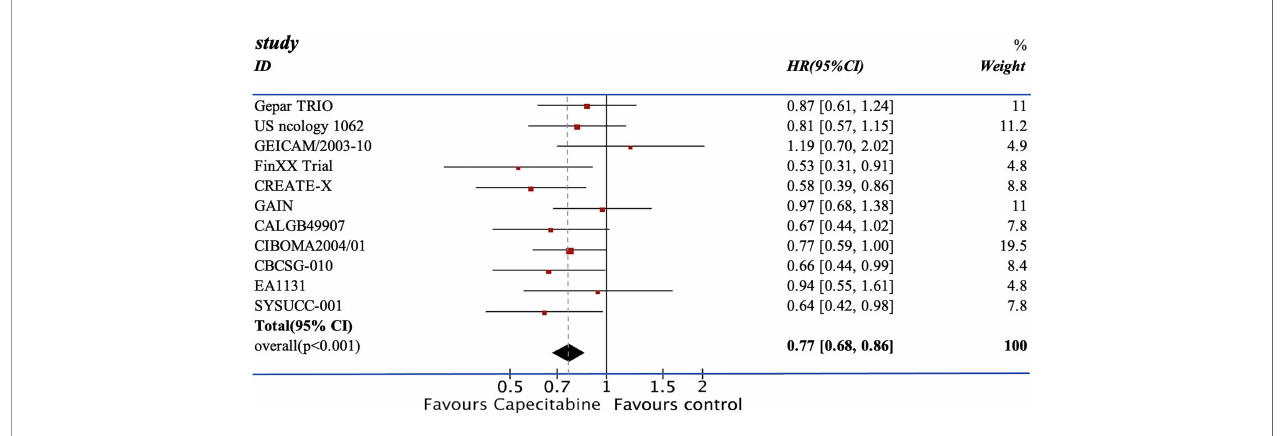
FIGURE 3 | The result of the DFS.